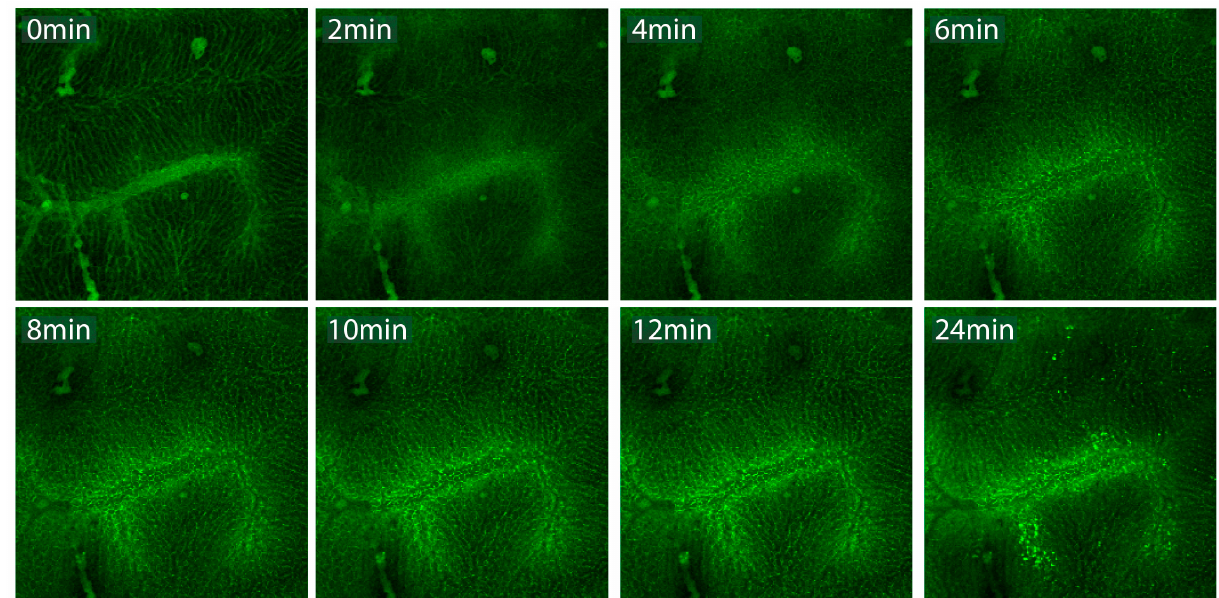
Figure 15. Hyperthermia-mediated intrahepatic liposomal drug delivery. At baseline temperature, carboxyfluorescein- loaded thermosensitive liposomes circulated through the hepatic microvasculature (t = 0 min). Subsequent HT application (41.0 °C; 24 min) gradually triggered content release from TSLs, resulting in the distribution of free CF, as shown by the increased extravascular intensity.